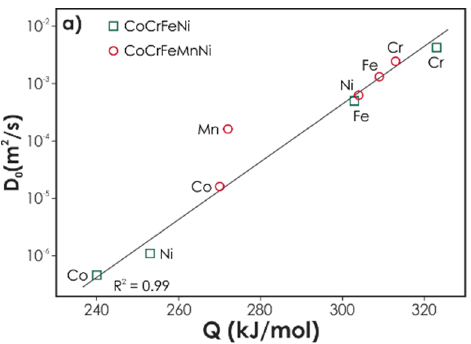
Figure 20. The pre-exponential factors for bulk diffusion in CoCrFeNi (squares) and CoCrFeMnNi (circles) as a function of respective activation energy E a (after [39]). Reprinted from Acta Materialia 146 (2018), Bulk tracer diffusion in CoCrFeNi and CoCrFeMnNi high entropy alloys, 211–224, Copyright 2018, with permission from Elsevier.